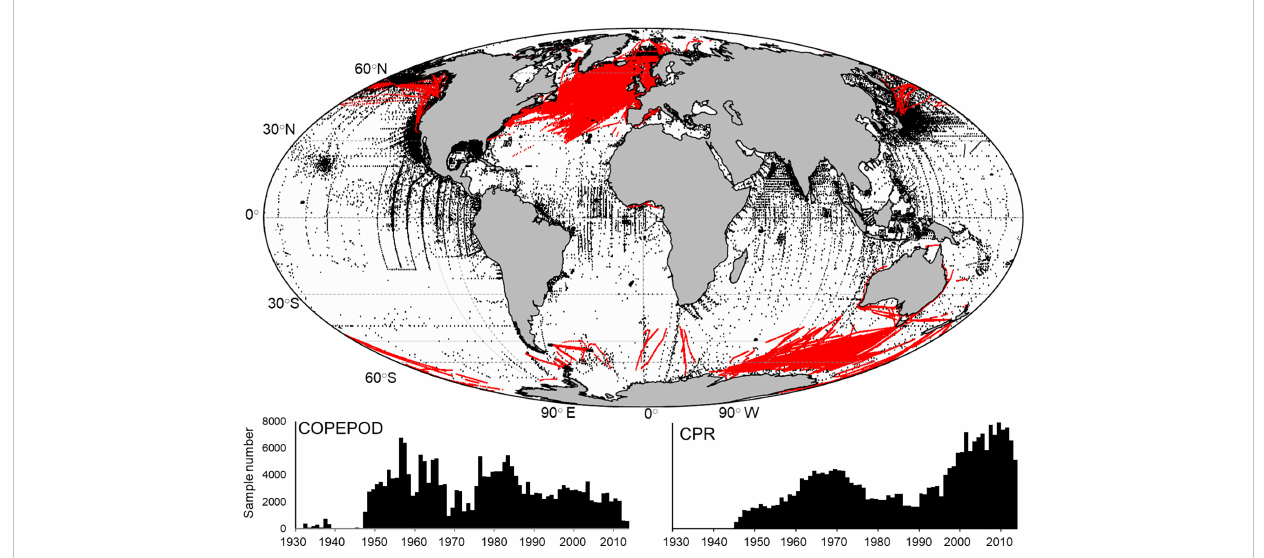
FIGURE 1 (top) The global distribution of surface (0-100 m) mesozooplankton biomass measurements from the COPEPOD database (black dots; n = 209,688) and samples taken from the Continuous Plankton Recorder (red dots; n = 264,512). Also shown is the sample frequency for each year for both the COPEPOD (bottom left) and CPR (bottom right)